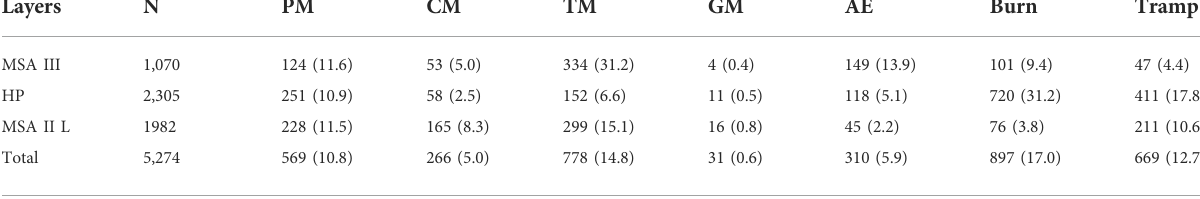
TABLE 7 Bone surface modi fi cation at Klasies River. Percentages in brackets. PM = percussion marks. CM = cut marks. TM = tooth marks. GM = gnaw marks. AE = acid etching. Burn = burnt bone. Tramp = trampling marks. %ShC = percentage of circumferentially complete long bone shafts.